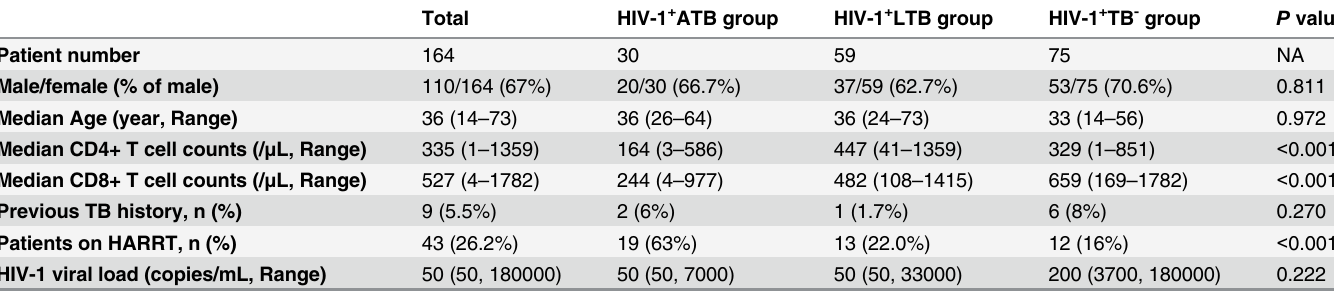
Table 1. Demographic and clinical characteristics of study subjects.